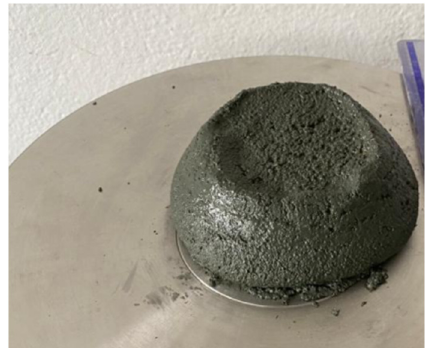
Figure 8. The view of slump-flow of glass wool-based geopolymer fresh mortar with Al 2 O 3